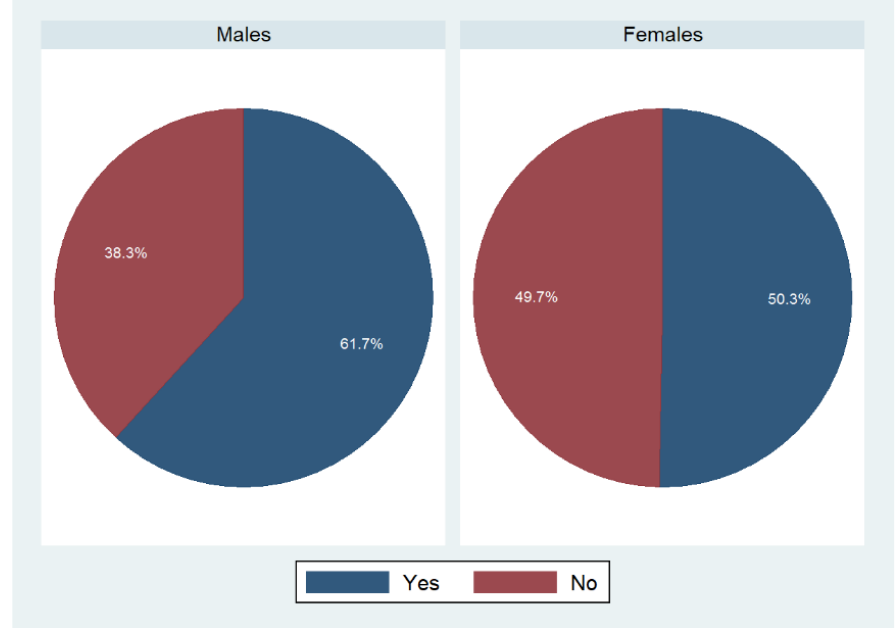
Figure 4. Sharing of food shopping duties stratified by gender: an overview. Weighted percentages, n = 9087; p < 0.001 based on a Rao – Scott test exploring potential associations between main person shopping and sex .